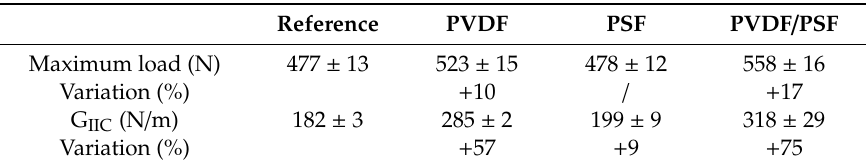
Table 5. The influence of PCL film, Nylon 66 nanofibrous mat, and their mixture on G IIC [39].